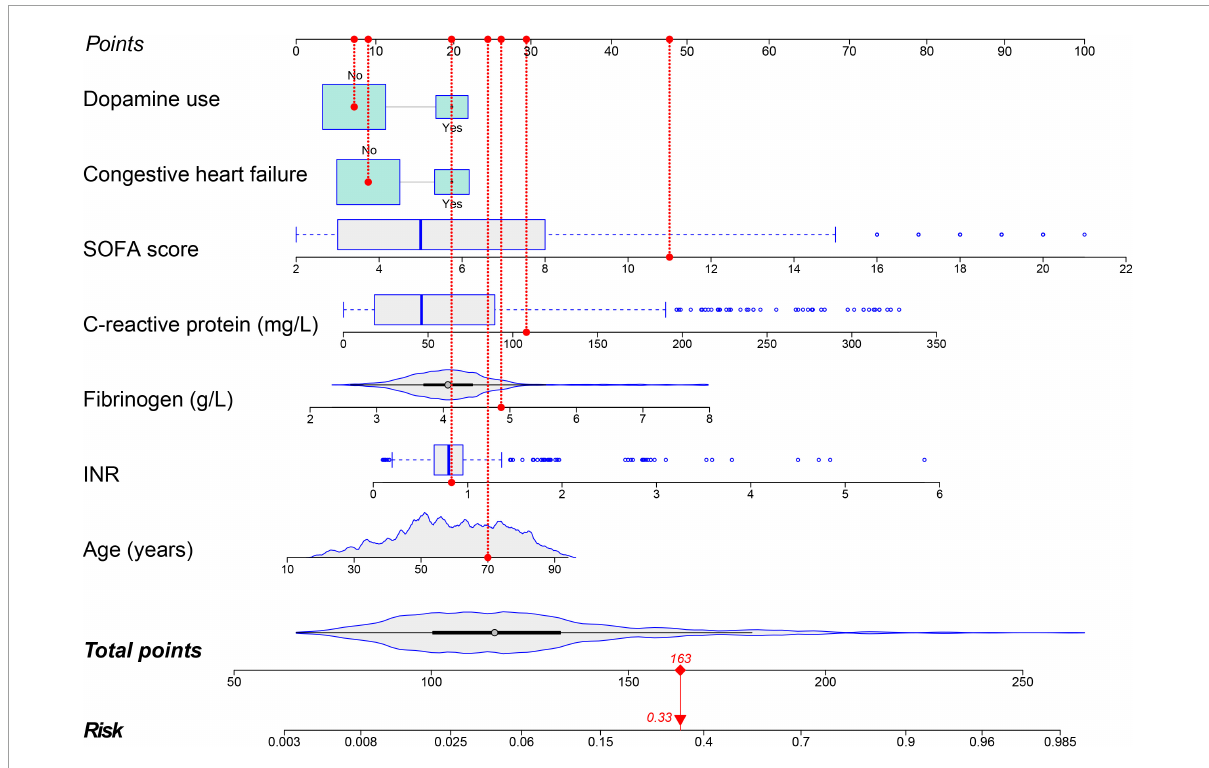
FIGURE4 Nomogram for predicting the risk of new-onset atrial fibrillation in patients with sepsis. A 70-year-old patient with sepsis and no history of congestive heart failure. During hospitalization INR was 0.83, fibrinogen was 4.87 g/L, C-reactive protein was 108 mg/L, SOFA score was 11, and dopamine was not used during treatment. This patient had a total score of 163 and a 33.0% risk of developing new-onset atrial fibrillation.